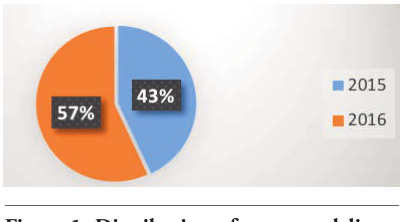
Figure 1. Distribution of cesarean delivery indications at DBRH from January, 2015 to December, 2016.